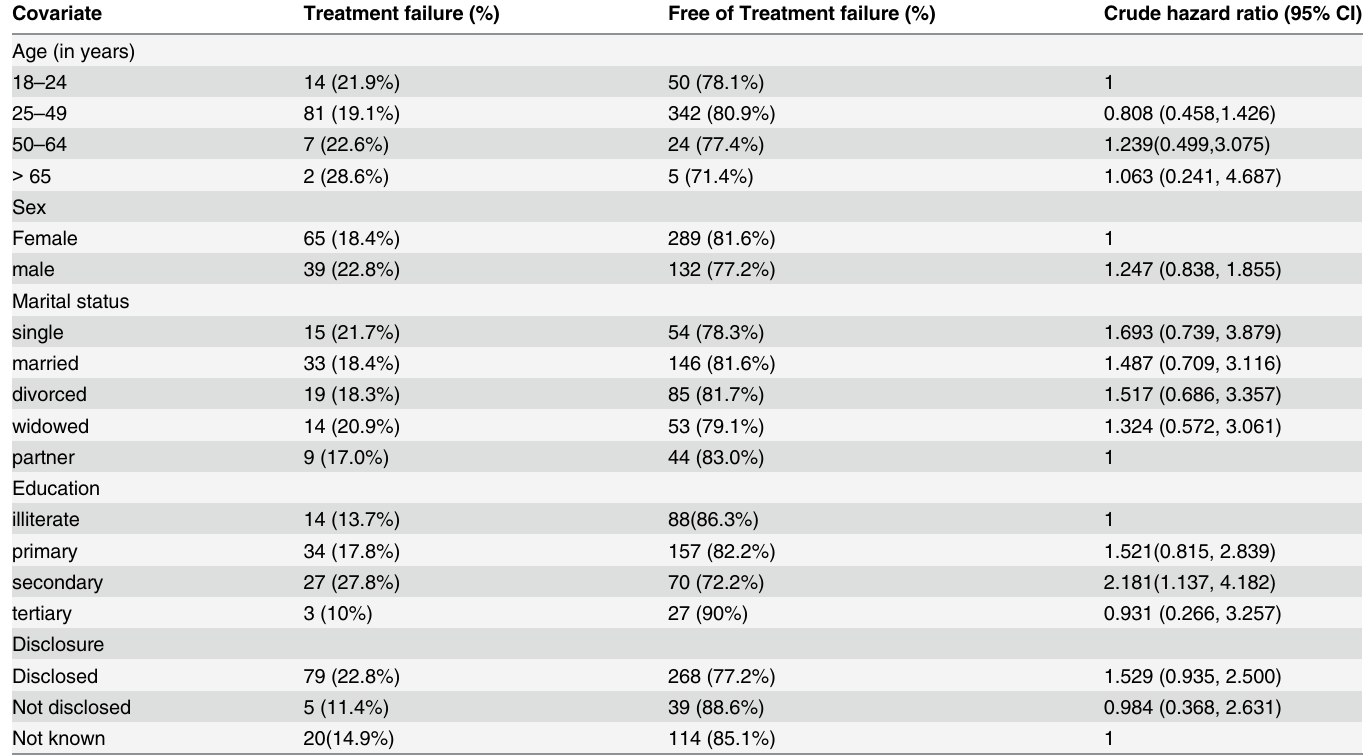
Table 4. Socio demographic characteristics as predictors of first line ART treatment failure in adults in private health facilities in Addis Ababa, 2009 –